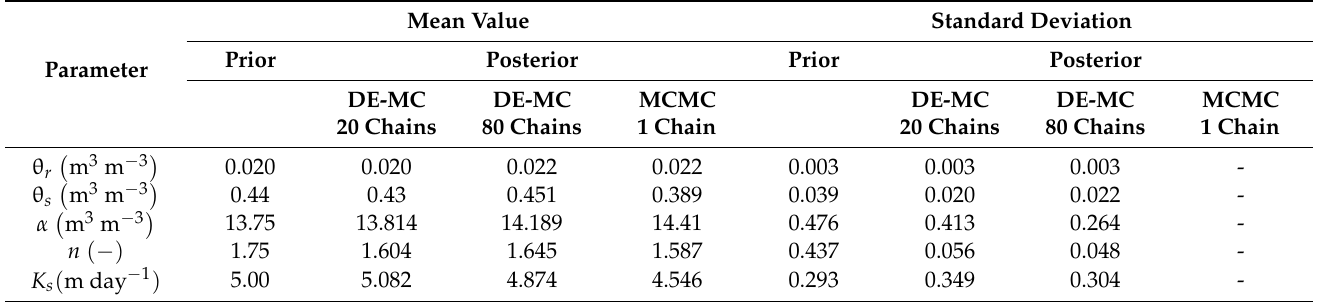
Figure 3. Comparison of the prior and posterior PDF of the parameters with the true values (black dotted line denotes true value). Table 2. Mean values and standard deviations of the prior and posterior PDF of the